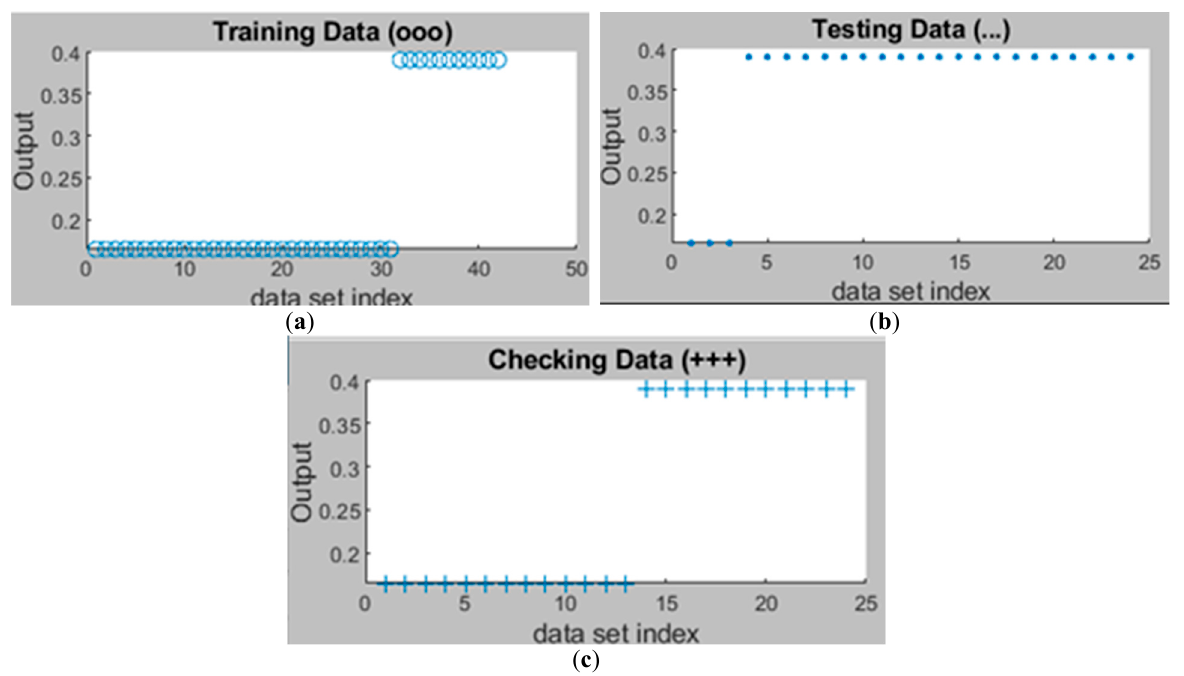
Figure 16. Data-set index for ( a ) training, ( b ) testing and ( c ) checking, respectively.